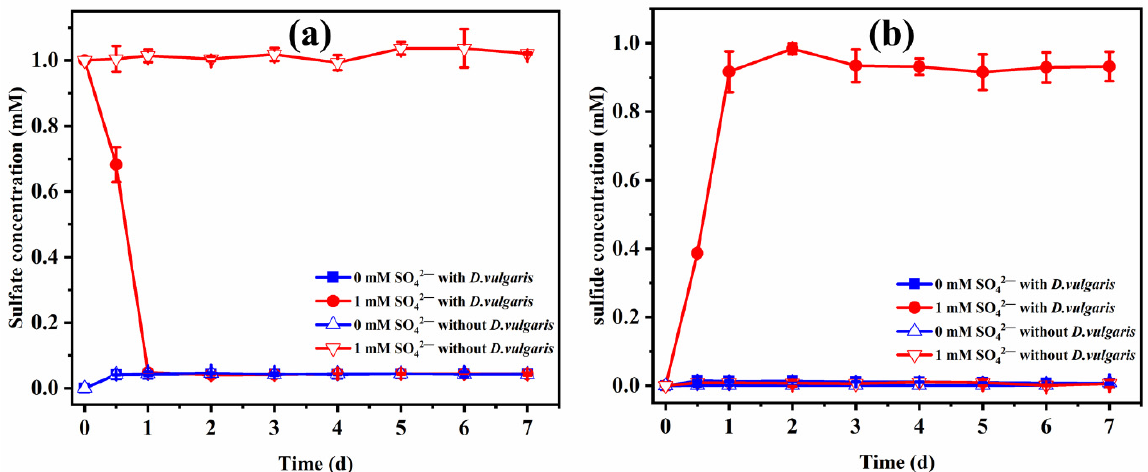
Figure 5. The changes of sulfate ( a ) and sulfide ( b ) concentrations during As(V) reduction experiment. Error bars indicate standard deviation of triplicates.